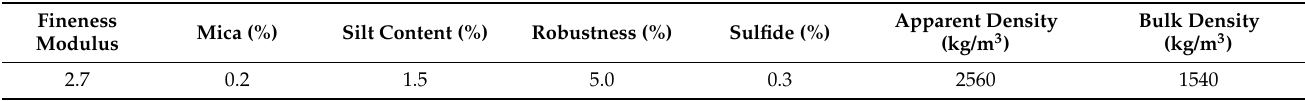
Table 5. Properties of coarse aggregate.